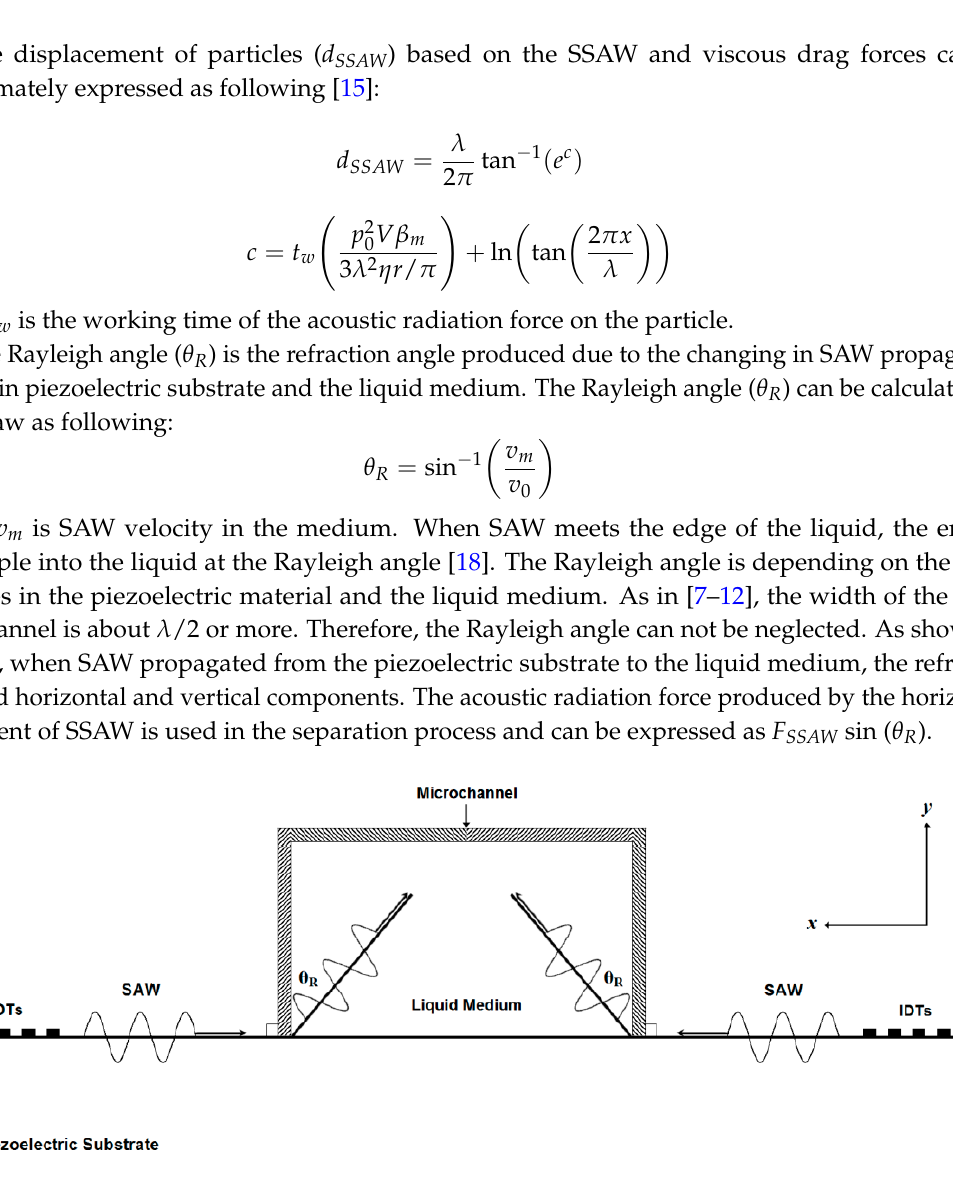
R ) affect on the propagation of